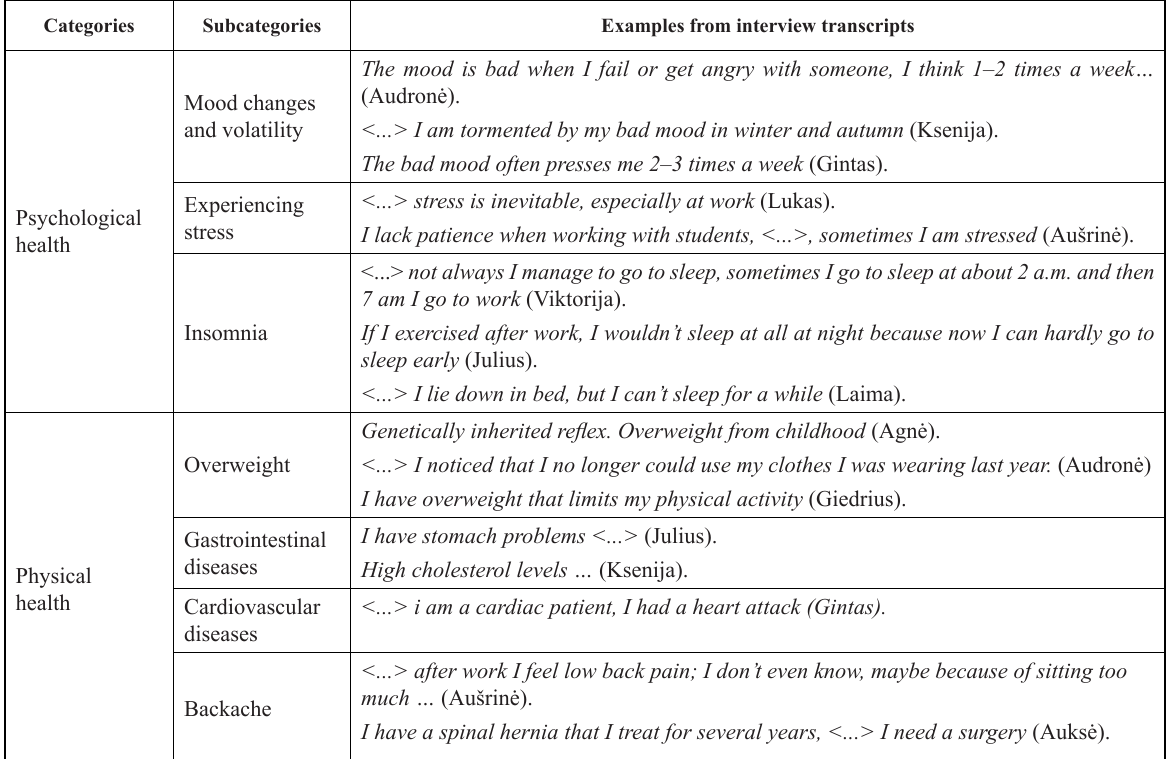
Table 2. Physical and psychological health of research participants